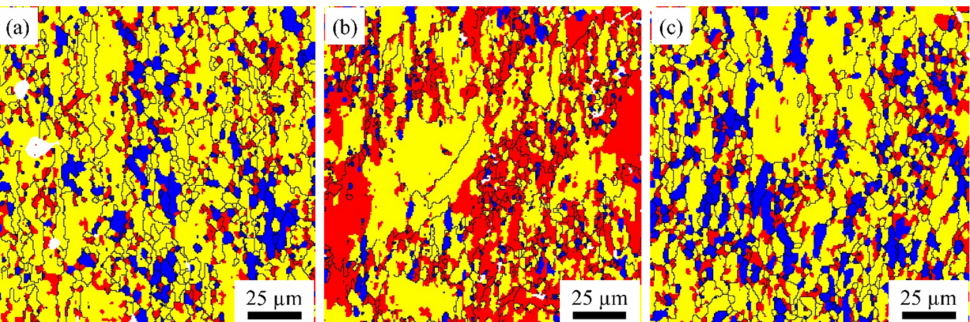
Figure 6. Recrystallization diagrams of samples at different rolling temperatures after aging treatment: S420 ( a ), S450 ( b ), S480 ( c